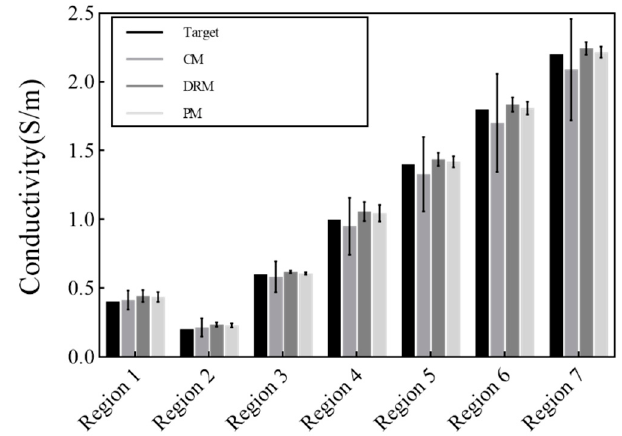
Figure 3. Bar graph of reconstructed conductivity value using conventional method (CM), double regularization method (DRM), and proposed method (PM). It corresponds to seven regions.